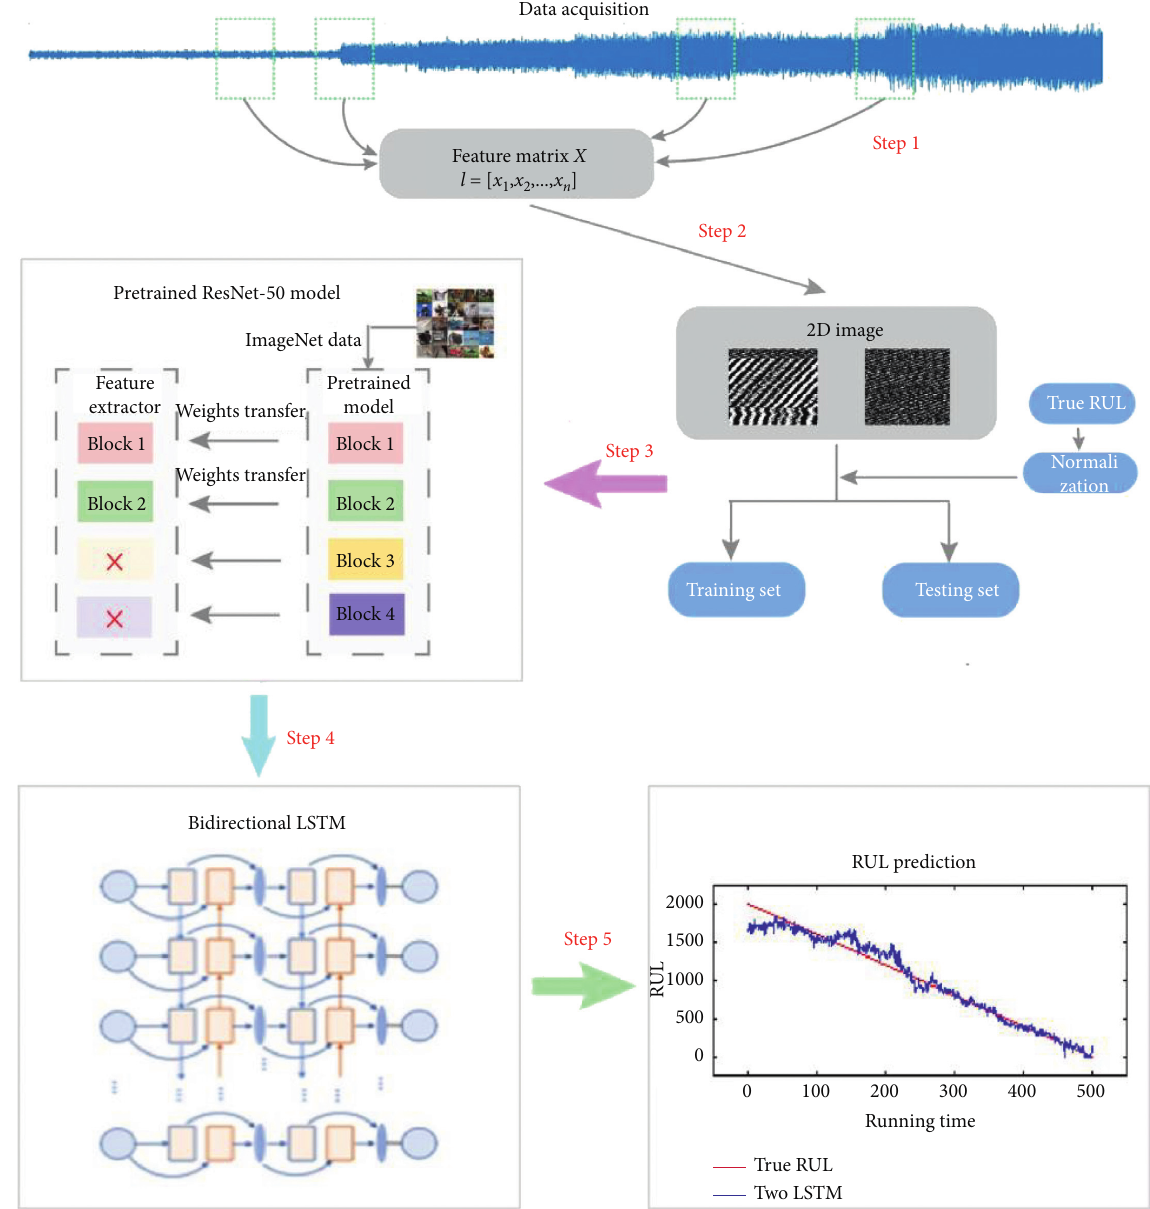
Figure 6: The flowchart of the proposed RUL